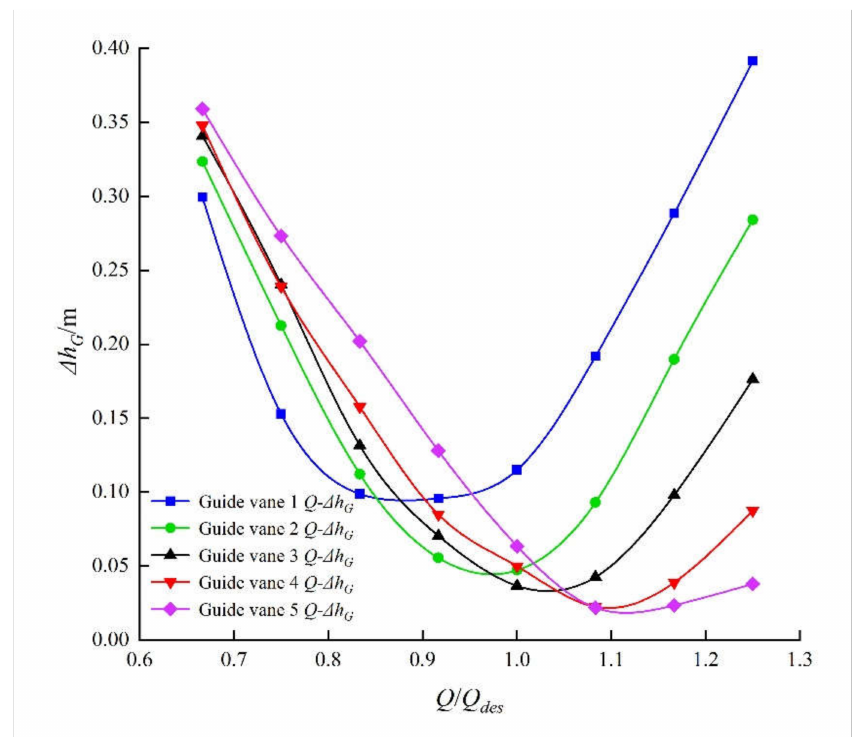
Figure 10. Hydraulic loss of guide vane (different guide vane